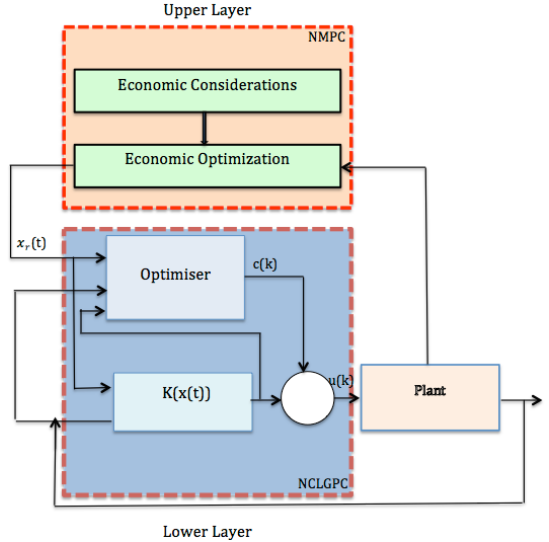
Figure 1. A block diagram of the proposed two-layer framework. In (6), the first constraint corresponds to the nominal model of the system, used to predict the future evolution of the states. The second constraint defines the initial condition of the optimization, which is the measurement of the state at instant t k . The third constraint presents the control limitation of all manipulated inputs. The fourth constraint limits the rate of change of the state trajectory. The fifth constraint ensures that the economically optimal state trajectory is maintained in the domain Ω . The last two constraints of the optimization problem of Equation (6) are used to guarantee closed-loop stability under this integrated framework and to ensure that the lower layer can force the system to track the state trajectory. This is a departure from other types of two-layer dynamic economic optimization architectures such as dynamic real-time optimization. The constraint on the rate of change of the economically optimal trajectory does pose a restriction on the feasible set of the optimization problem of Equation (6) and, thus, can affect the closed- loop economic performance of the control framework. However, a system that requires a large rate of change on the trajectory to achieve closed-loop economic performance that is better than steady-state may be undesirable for many applications based on practical considerations such as excessive strain on control actuators as well as the difficulty of forcing the system to track a rapidly changing operating trajectory in the presence of